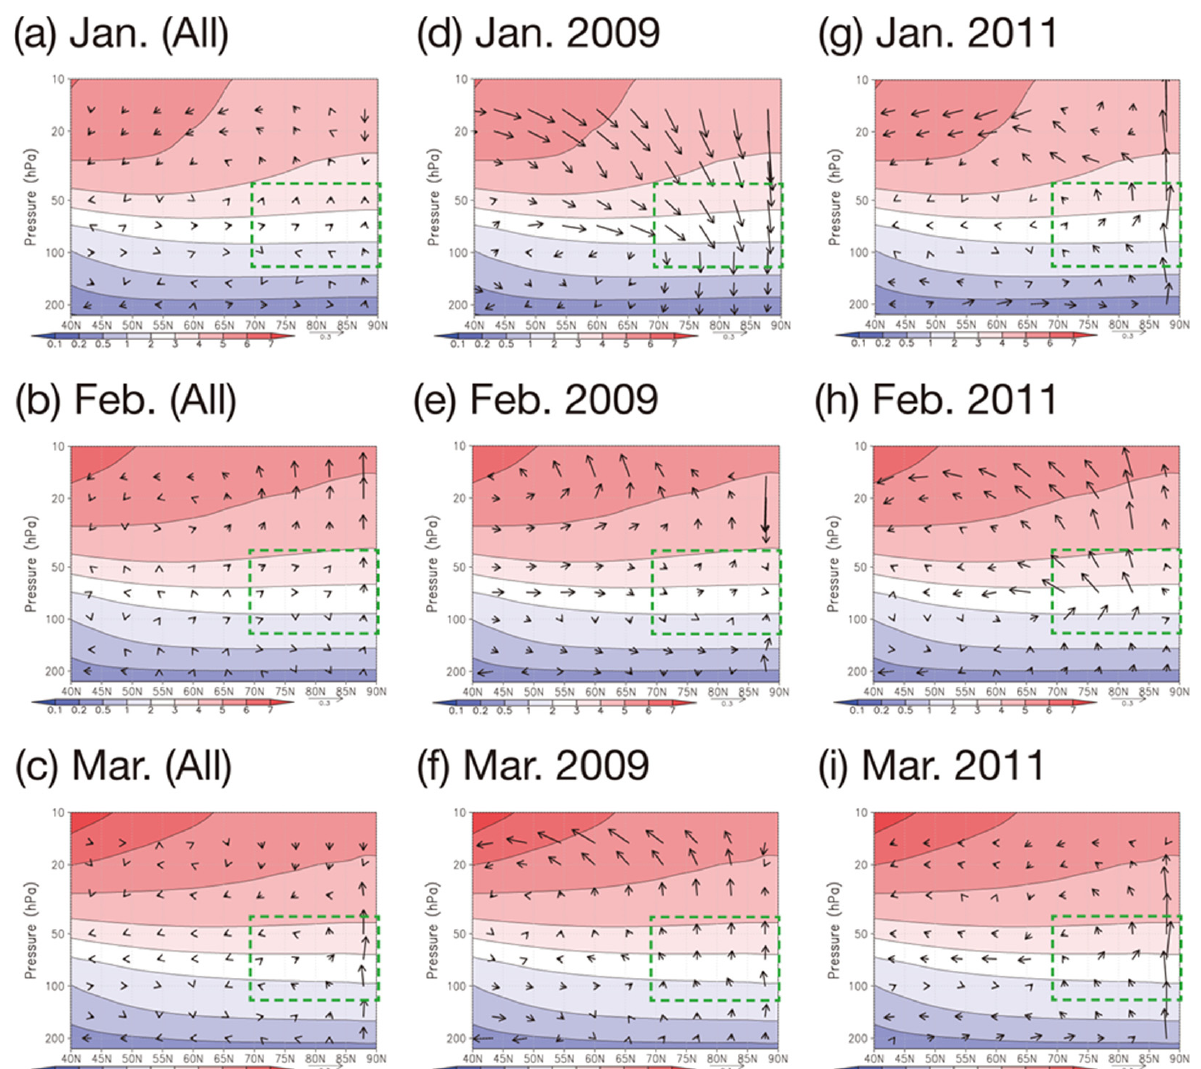
Figure 9. Residual mean meridional circulation anomaly for the QBO-W/S min years in ( a ) January, ( b ) February, and ( c ) March. The vertical component of the residual circulation is magnified by a factor of 200 relative to the horizontal component, and the scale for the horizontal vector is shown at the bottom right of the panel in units of m/s. The contours/shadings indicate the ozone mixing ratio averaged for 1979–2011 with units of DU. ( d – f ) Same as ( a – c ), respectively but for anomalies in 2009. ( g – i ) Same as ( a – c ) but for anomalies in 2011.